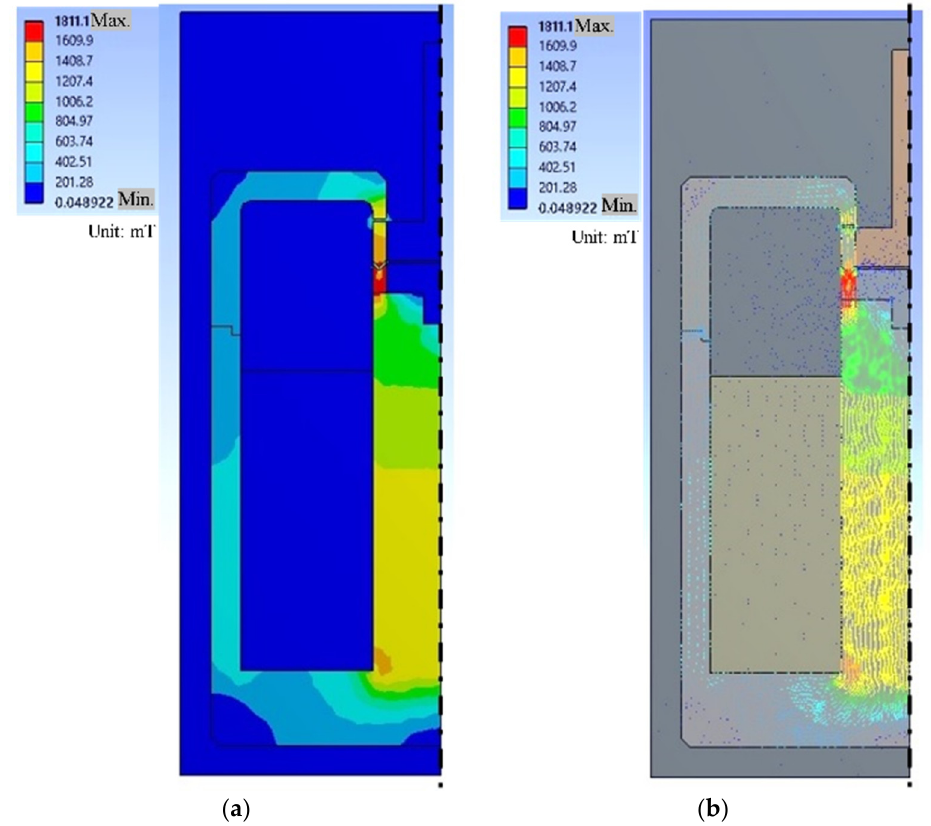
Figure 9. Distribution of magnetic field in the V-shaped plate setting (full view). ( a ) Contour, ( b ) vector.